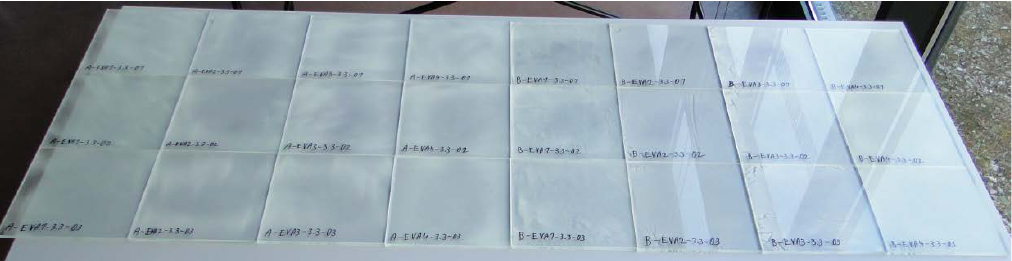
Fig. 9 Samples for the durability test with sprayed paint